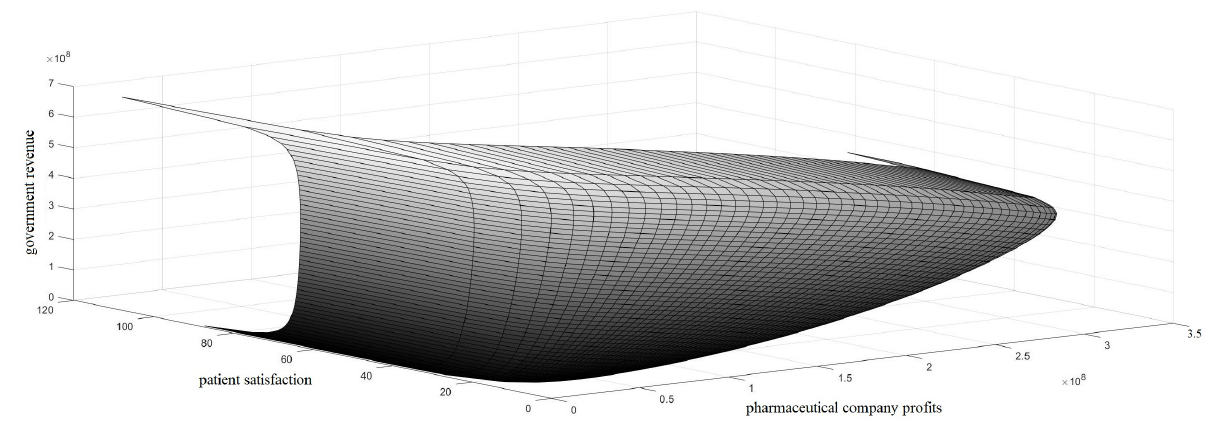
Figure 1. The interests of the government, pharmaceutical companies, and patients .